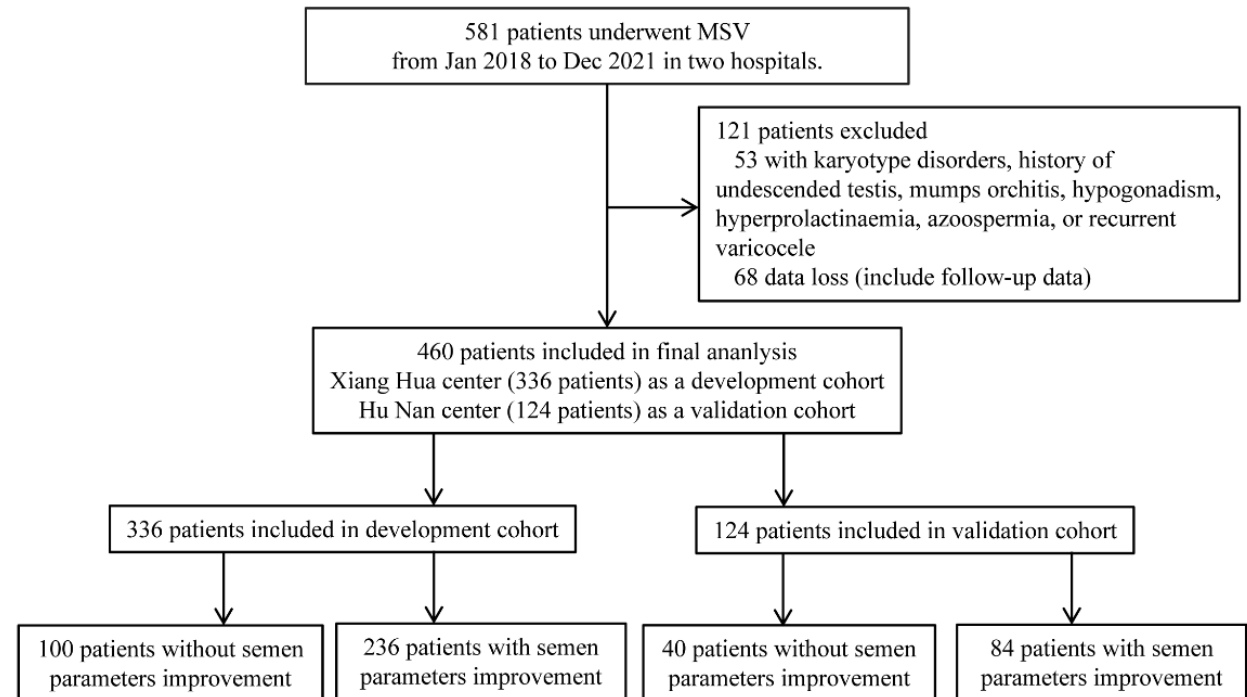
Figure 1. Flowchart of this study.